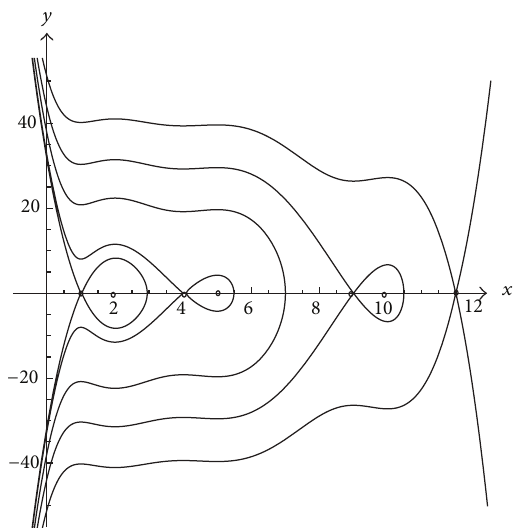
Figure 2: The phase portrait of (15), 𝜆 = 0.0343 .